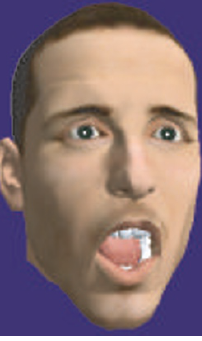
Figure 8: A surprise expression form our template model